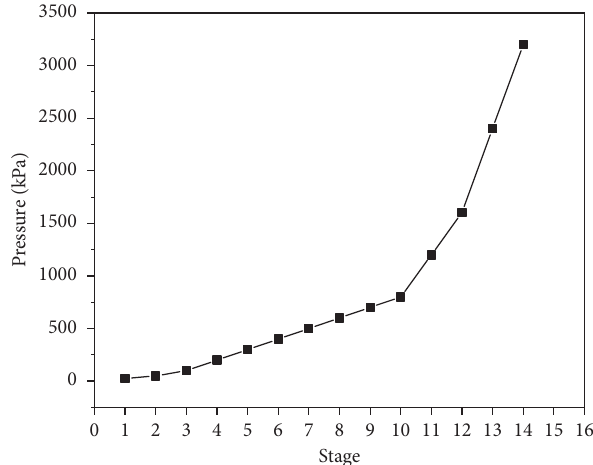
Figure 3: Pressure setting for high-pressure consolidation